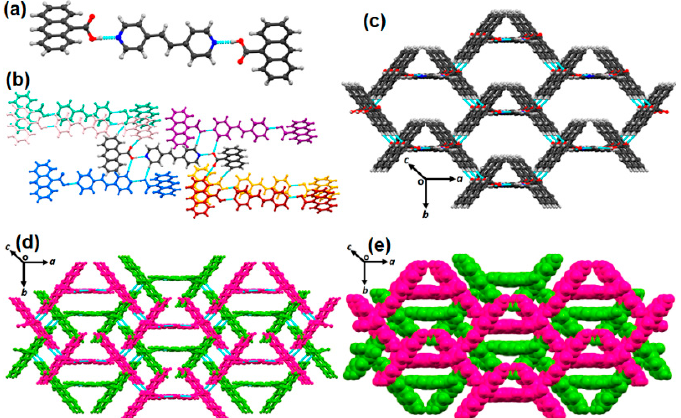
Figure 1. Crystal structure of 9-anthracene carboxylic acid-1,2-bis(4-pyridyl)ethylene (ACA-BPEE): ( a ) ACA and BPEE molecules form a trimeric motif mediated by acid–pyridine hetero-synthon. ( b ) Each trimeric motif is connected with six different supramolecular motifs (presented in different colors) by C–H···O interactions. ( c ) View of a single 3D hydrogen-bonded network showing a large void. ( d , e ) Two-fold interpenetrating networks in the ball and stick and space fill models, respectively. Table 1. Crystallographic and structural refinement parameters of 9-anthracene carboxylic acid-1,2- bis(4-pyridyl)ethylene (ACA-BPEE) and ACA-1,2-bis(4-pyridyl)ethane (BPE) cocrystals.